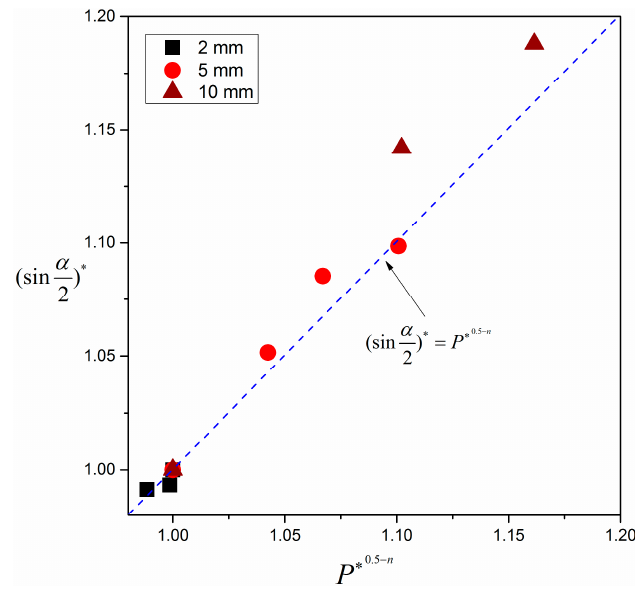
Figure 8. Non-dimensional dependence of sin( 2) on pressure.